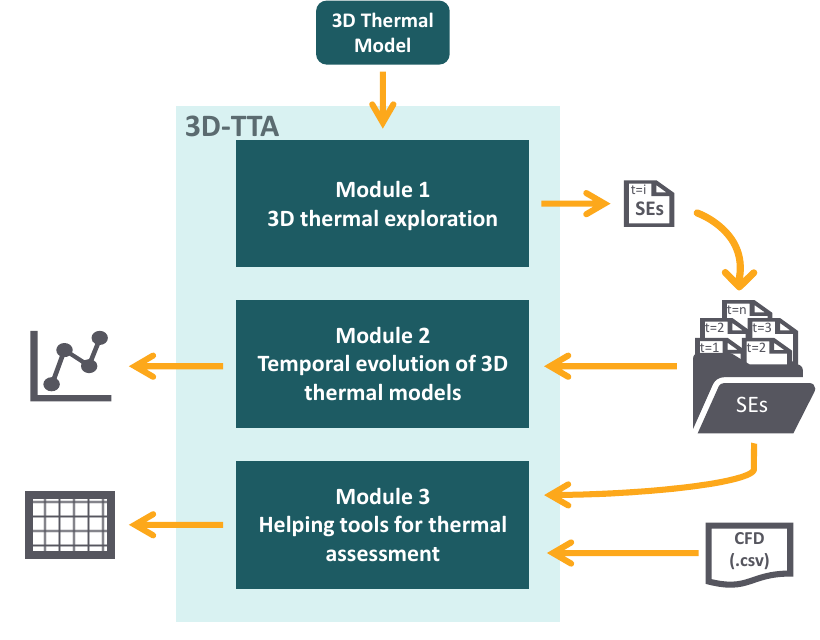
Figure 2. Main modules of 3D-TTA.